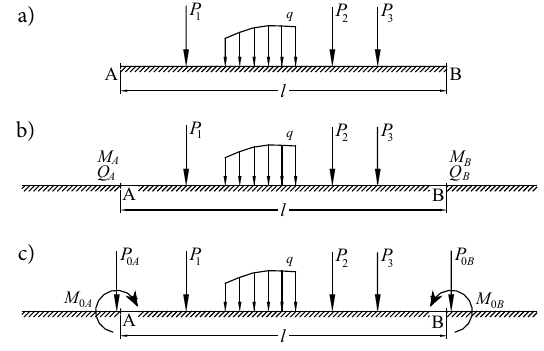
Fig. 2. Infinite beam subjected to various loads